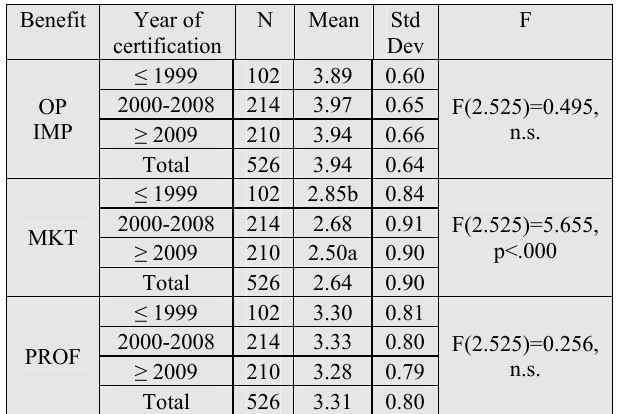
Table 4. ISO 9001 Benefits as a function of the year of certification Benefit Year